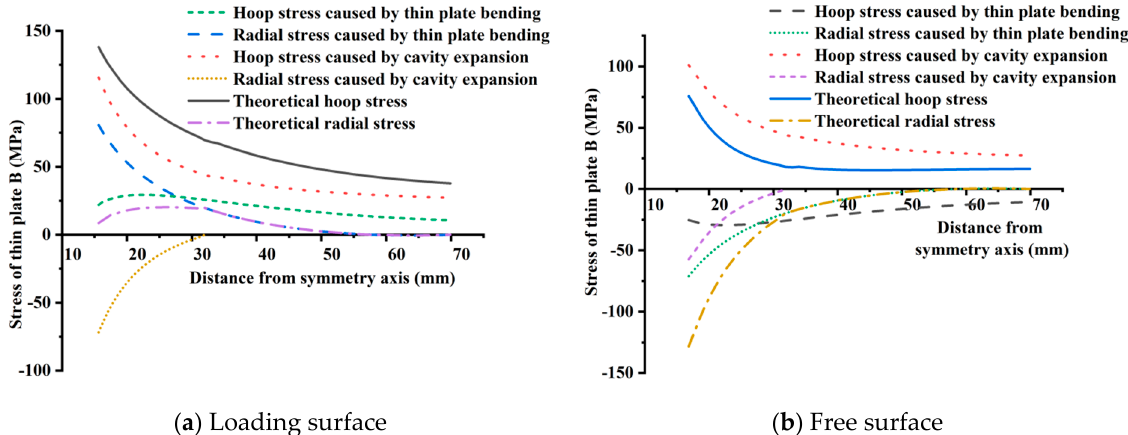
Figure 13. The stress superposition of the loading and free surface of the thin plate B.